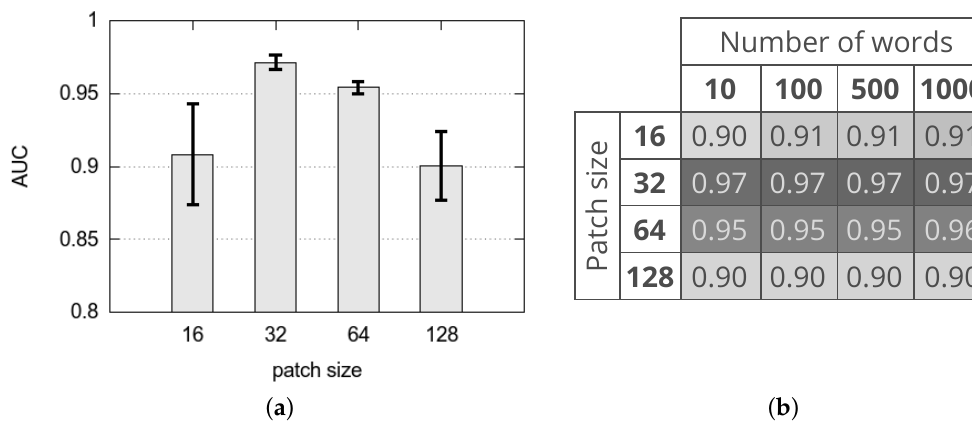
Figure 7. Area Under the Curve achieved with different variants of the proposed method. ( a ) average and standard deviation of the Area Under the Curve (AUC) achieved with different patch sizes whatever is the Convolutional Neural Network (CNN) layer adopted for feature extraction, whatever is the use of PCA to reduce the size of the feature vector and whatever is the number of words of the dictionary; ( b ) average of the AUC achieved with different patch sizes and number of words of the dictionary whatever is the CNN layer adopted for feature extraction and whatever is the use of PCA to reduce the size of the feature